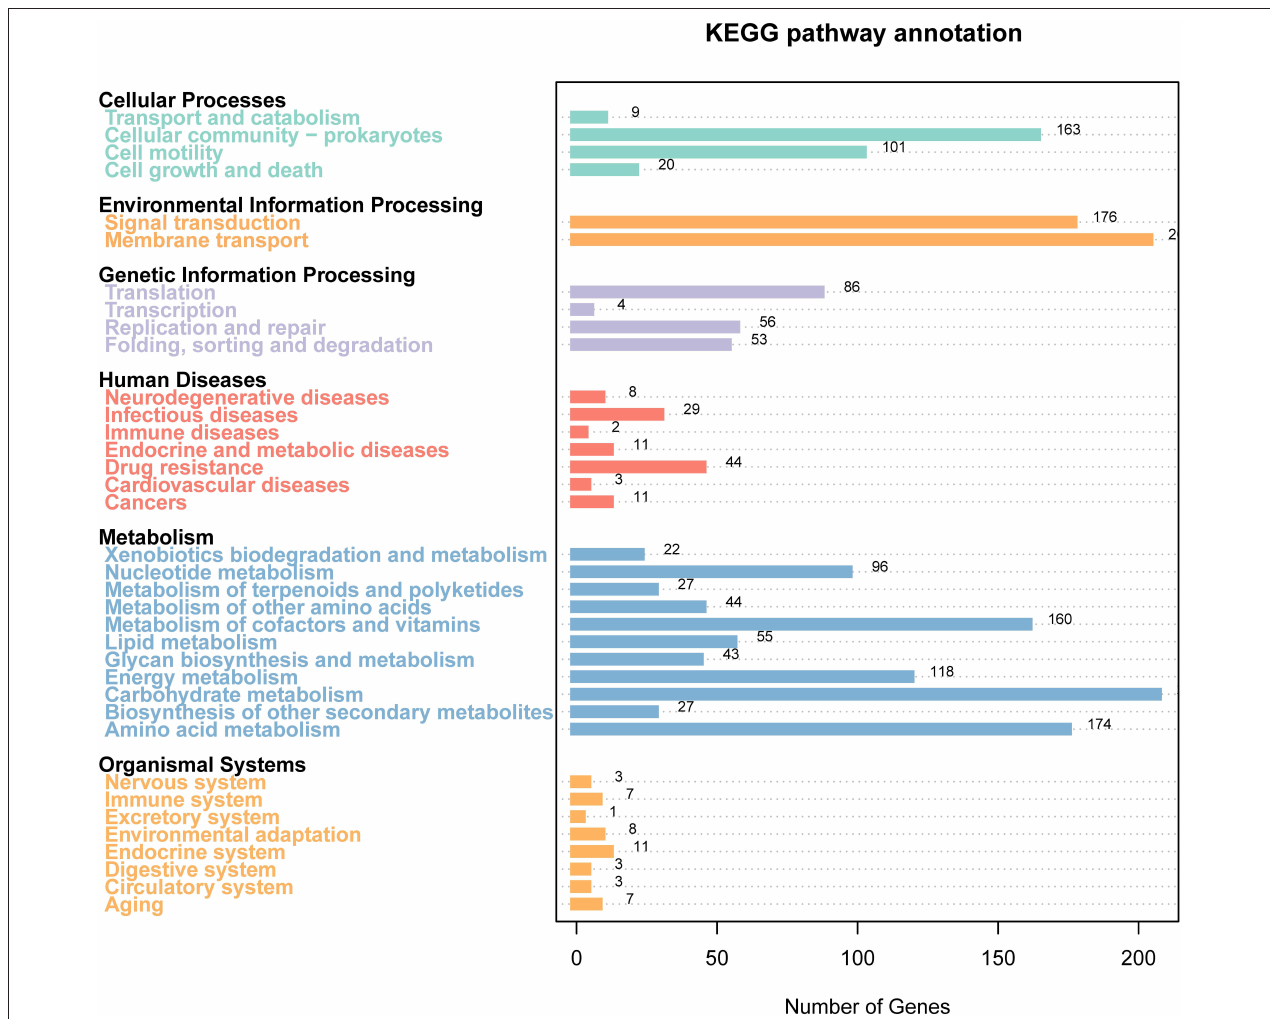
FIGURE 4 | Gene distribution based on the Kyoto Encyclopedia of Genes and Genomes (KEGG) classification of non-O1/O139 V. cholerae GXFL1-4.